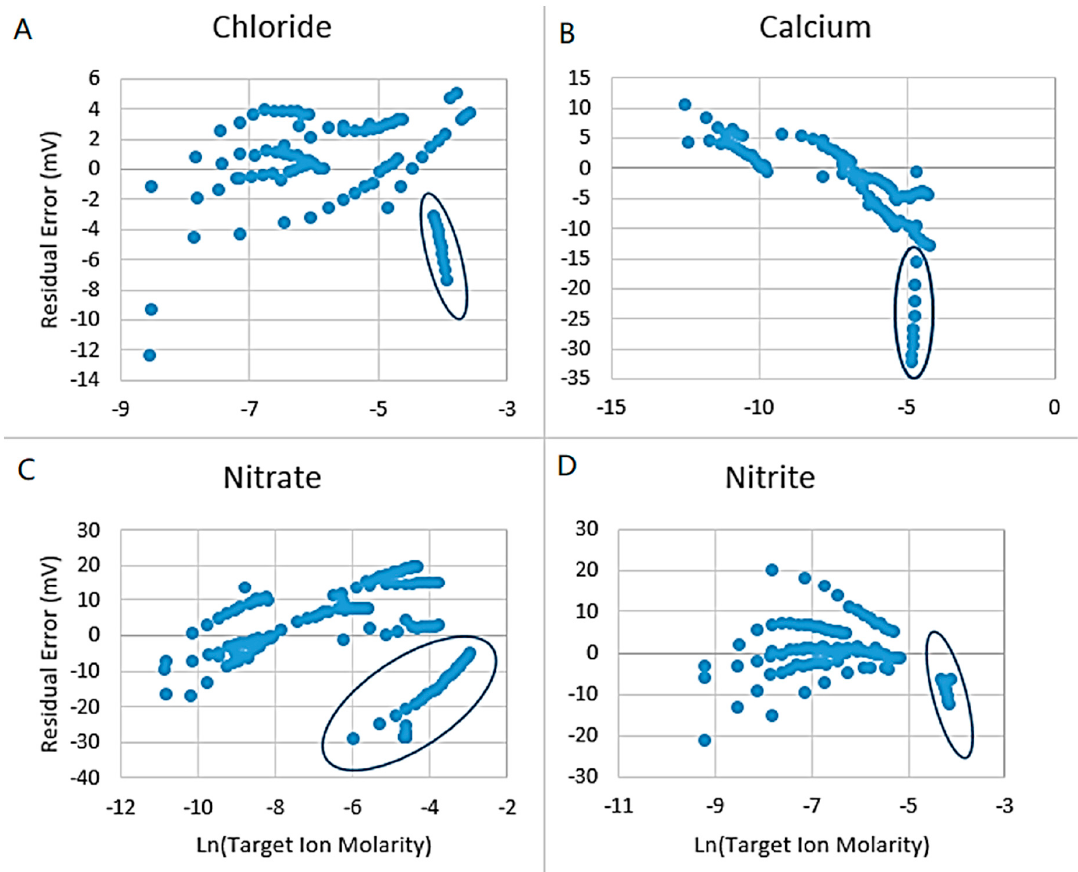
Figure 2. Supplementary Control Experiments Demonstrating Error in The Modified Nernst Equation for ( A ) Chloride; ( B ) Calcium; ( C ) Nitrate; ( D ) Nitrite. Encircled data sets have only variation in ionic strength. This error is directly from assuming direct proportionality of activity and